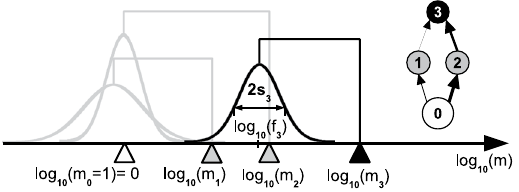
Figure 1. Model illustration using 4 morphs. Morph 3 (black triangle) is characterised by its body mass m 3 , the centre of its feeding range f 3 , and the width of its feeding range s 3 . The Gaussian function (black curve) describes its attack rate kernel N 3 j on potential prey. Here, morph 3 feeds on morph 2 and 1 (grey triangles) with a high resp. low attack rate. Morph 1 and 2 are consumers of the external resource (white triangle). Also illustrated is the corresponding network graph. After 34